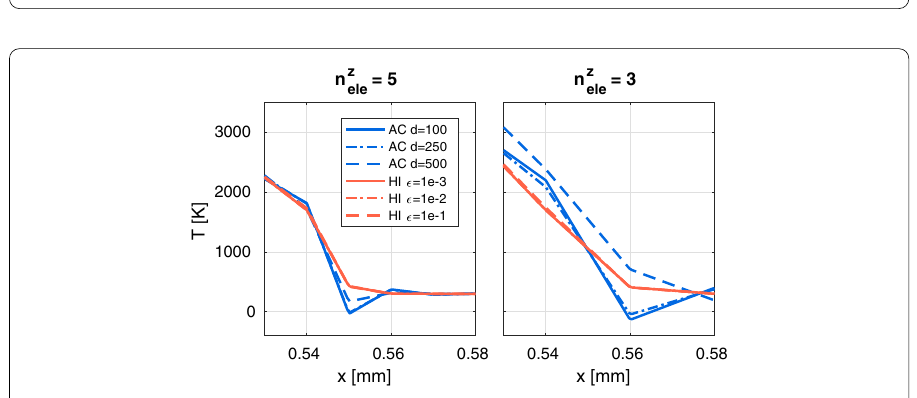
Fig. 22 Surface temperature profiles for AC with different phase change intervals along laser path (i.e. y = 0 . 0mm). Zoomed in to melting front